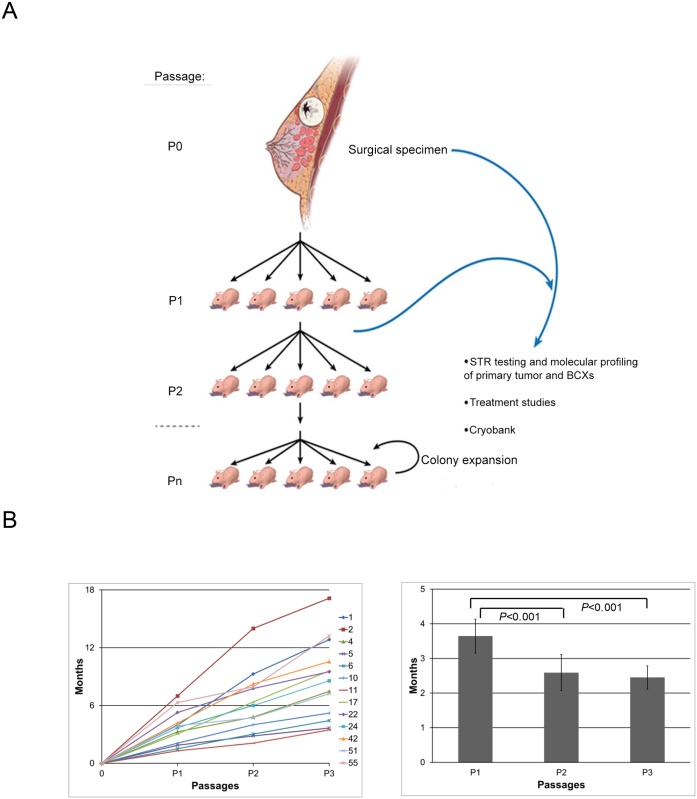
Generating and maintaining patient-derived breast cancer xenografts (BCXs) and their time to passage.(A) After surgery, patient tumors (P0) were implanted into nude mice, creating a patient-derived BCX, passage 1 (P1). When tumors reached 1.5 cm diameter, they were harvested and implanted into 5 new mice (P2), and subsequent passages respectively. Patient tumors and BCXs were evaluated by STR and selected passages underwent molecular and histologic characterization. (B) Y-axis depicts time to reach 1.5 cm with each passage. The graph shows thirteen BCXs that were serially passage. (C) Time to passage (in months) at from implantation to first passage (P1), P1 to P2 (P2), and P1 to P3 (P3). Time to passage at P2 and P3 were compared to time to passage at from implantation to first passage (P1).